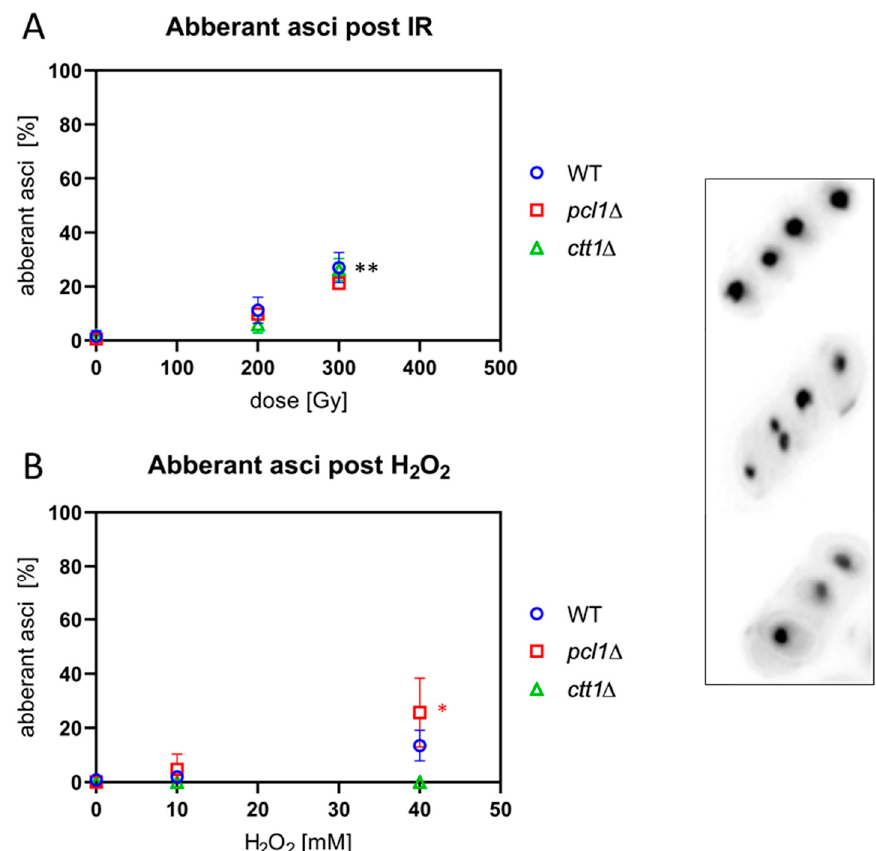
Figure 7. IR and ROS exposure induce aberrant asci, as shown in microscopic images on the right. The upper ascus contains 4 normal ascospores, while the two aberrant asci below show 5 and 3 spore nuclei, respectively. ( A ) X irradiation significantly increased the average frequency of aberrant asci in wild-type (WT), pcl1 ∆ , and ctt1 ∆ strains at 300 Gy (** p < 0.007) relative to sham IR. ( B ) H 2 O 2 exposure induced a not significant increase in the WT but a significant increase of aberrant asci in pcl1 ∆ at 40 mM (* p = 0.025). ctt1 ∆ meiocytes were killed by H 2 O 2 , blocking spore formation. Data points reflect the mean of three experiments (± SD).